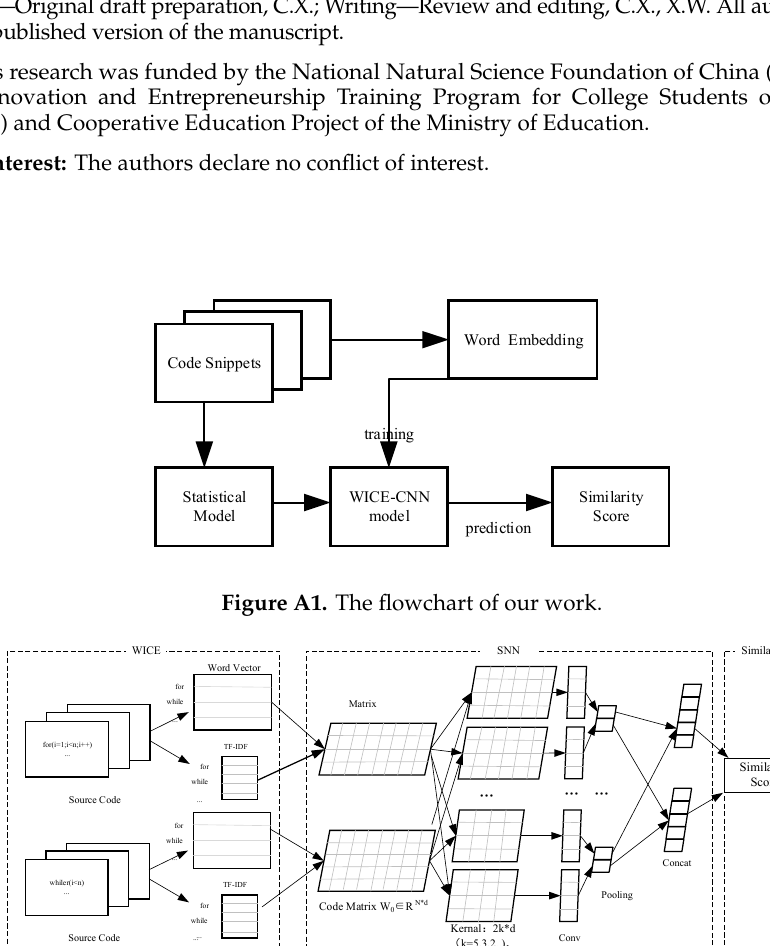
Figure A3. Performance Change with Parameter (Threshhold ∈ [0.1, 1]). Table A1. Results on Dataset1. Model